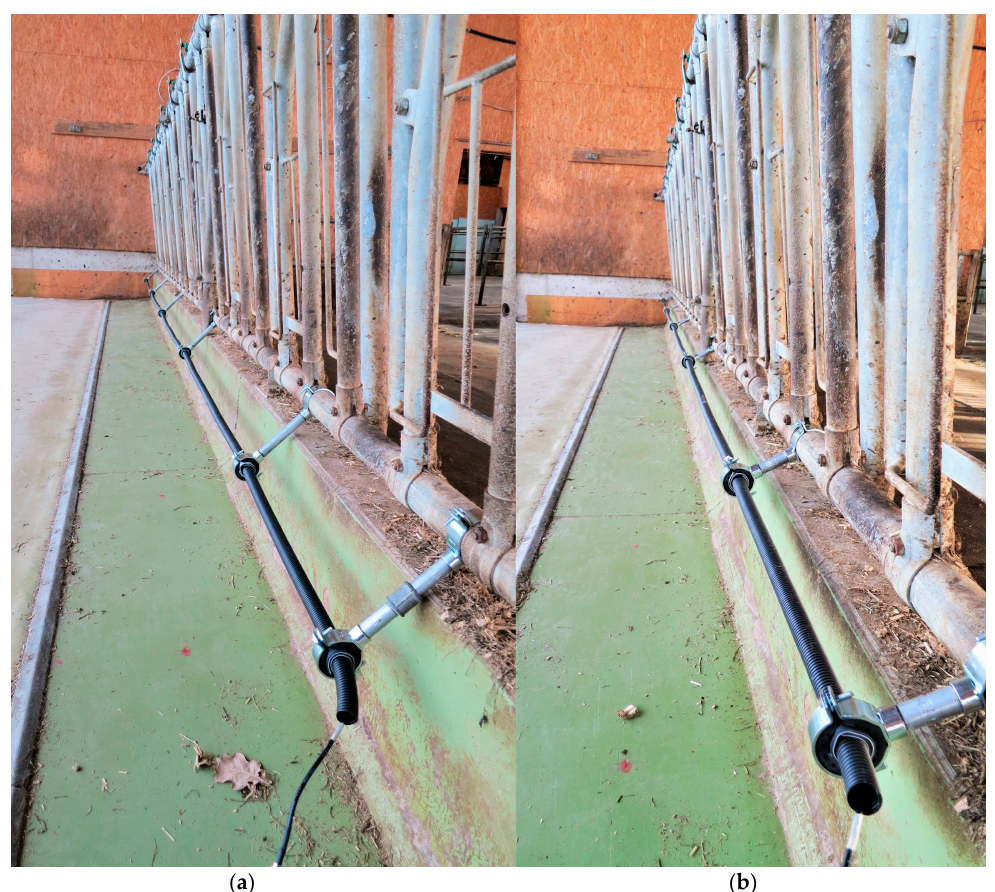
Figure 2. Setup of the antenna at the feed fence. ( a ) Antenna Position 1; ( b ) Antenna Position 2.